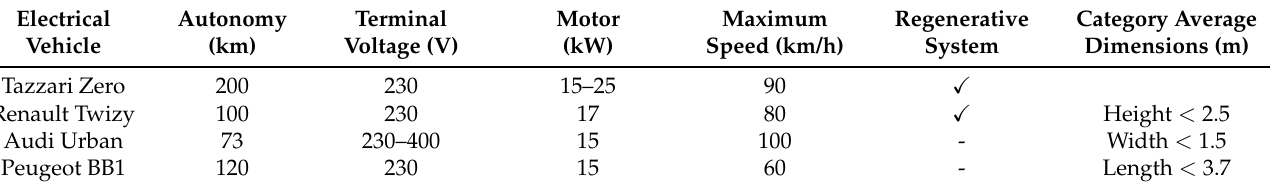
Table 1. European homologation class L7e-C